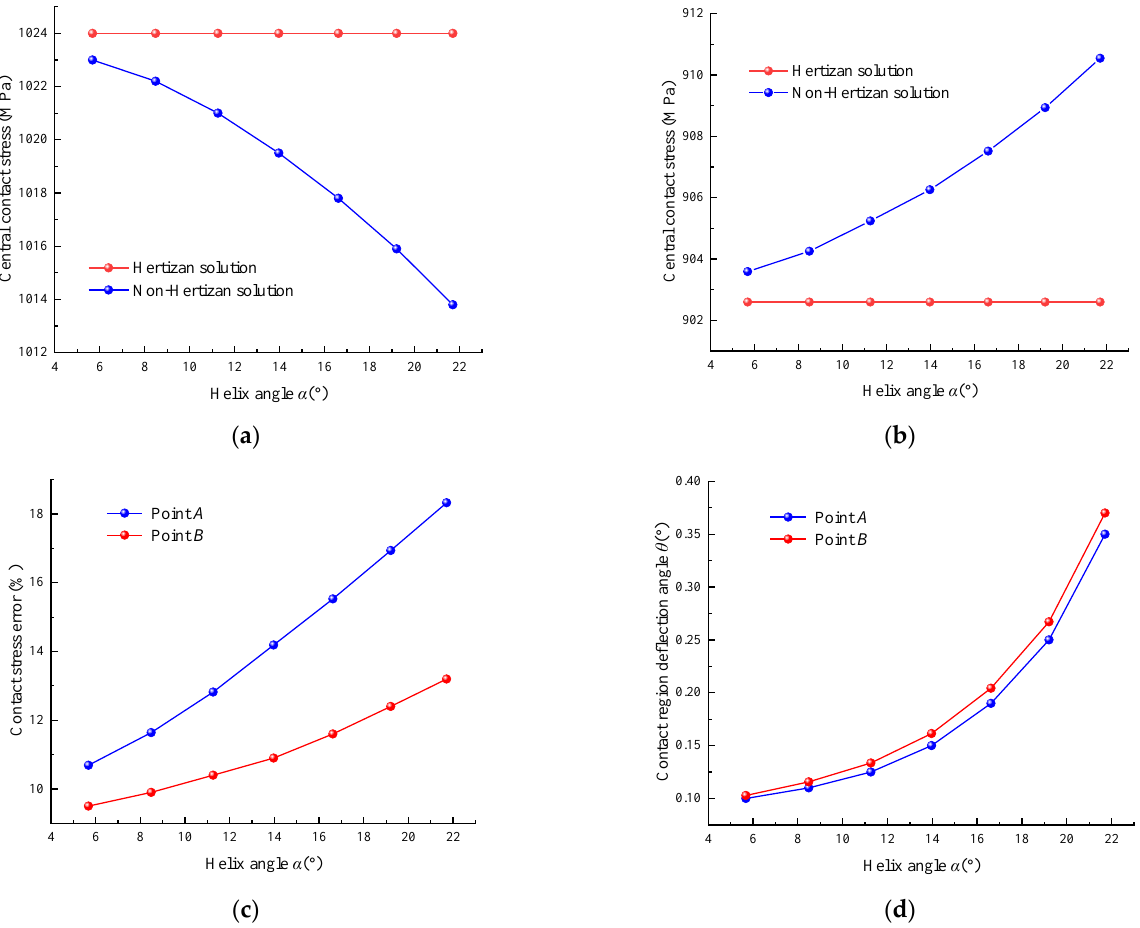
Figure 9. Comparison of the Hertzian and non-Hertzian contact stress. ( a ) The central contact stress of the point A. ( b ) The central contact stress of the point B. ( c ) The contact stress error. ( d ) The contact region deflection angle.